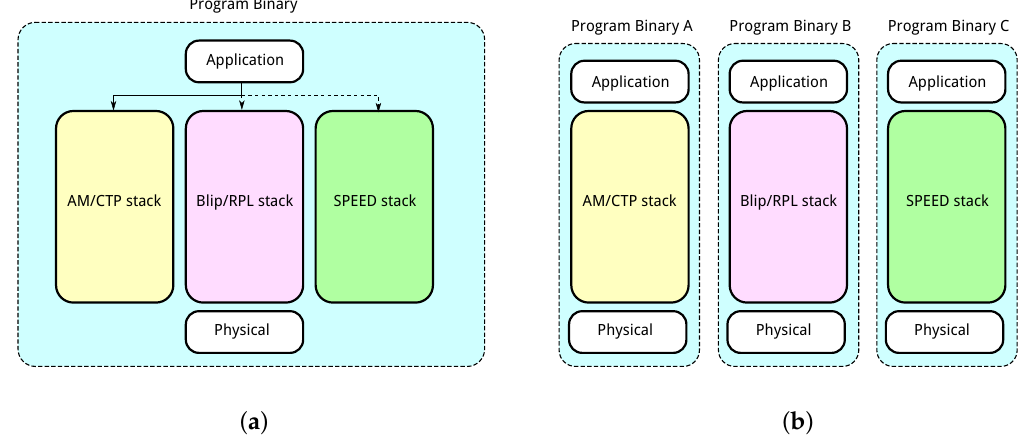
Figure 9. Single binary and multiple binary program solutions. ( a ) Program binary containing multiple communication solutions; ( b ) Multiple program binaries containing a single communication solution